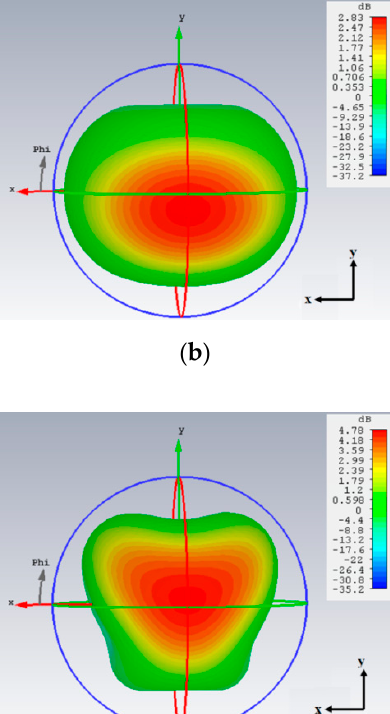
Figure 3. Antenna_1: ( a ) real and imaginary part of the antenna’s input impedance, ( b ) scattering coefficient of the feeding signal at the input of the antenna.